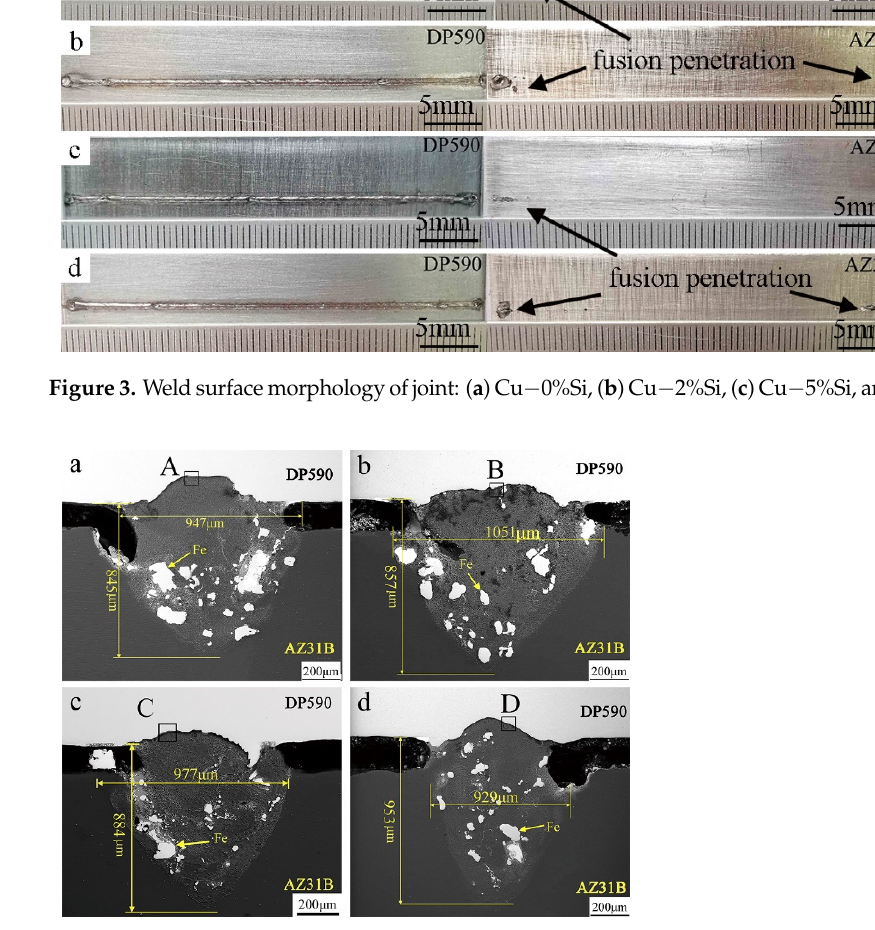
Figure 4. Weld appearance at the magnesium alloy side: ( a ) Cu − 0%Si, ( b ) Cu − 2%Si, ( c ) Cu − 5%Si, and ( d ) Cu − 8%Si.